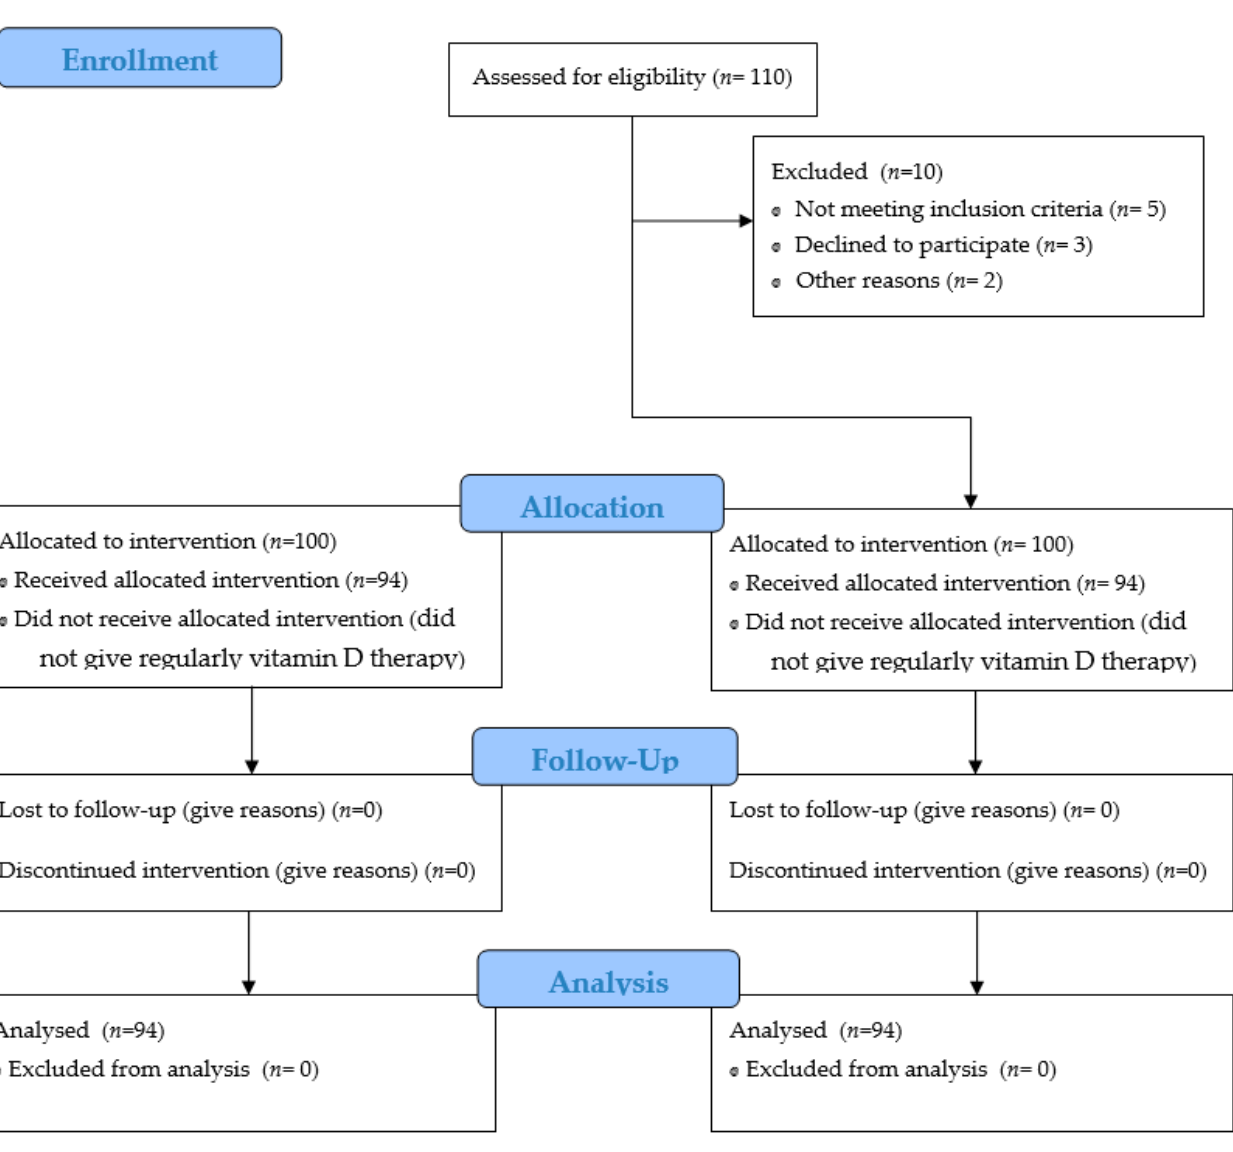
Figure 1. Flow Figure 1. Flow diagram.